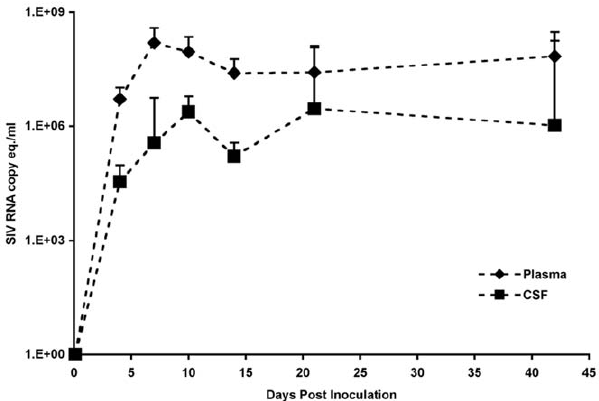
Figure 1. Quantitation of SIV virion RNA in plasma and CSF of SIV-infected macaques. SIV RNA was isolated from 140 m l of plasma and CSF collected at terminal time points from uninfected and SIV- infected macaques sacrificed at 4, 7, 10, 14, 21, or 42 days p.i. SIV RNA copy equivalents were determined by quantitative RT-PCR, and the means (diamonds for plasma and squares for CSF) and standard deviation for each experimental group are indicated.